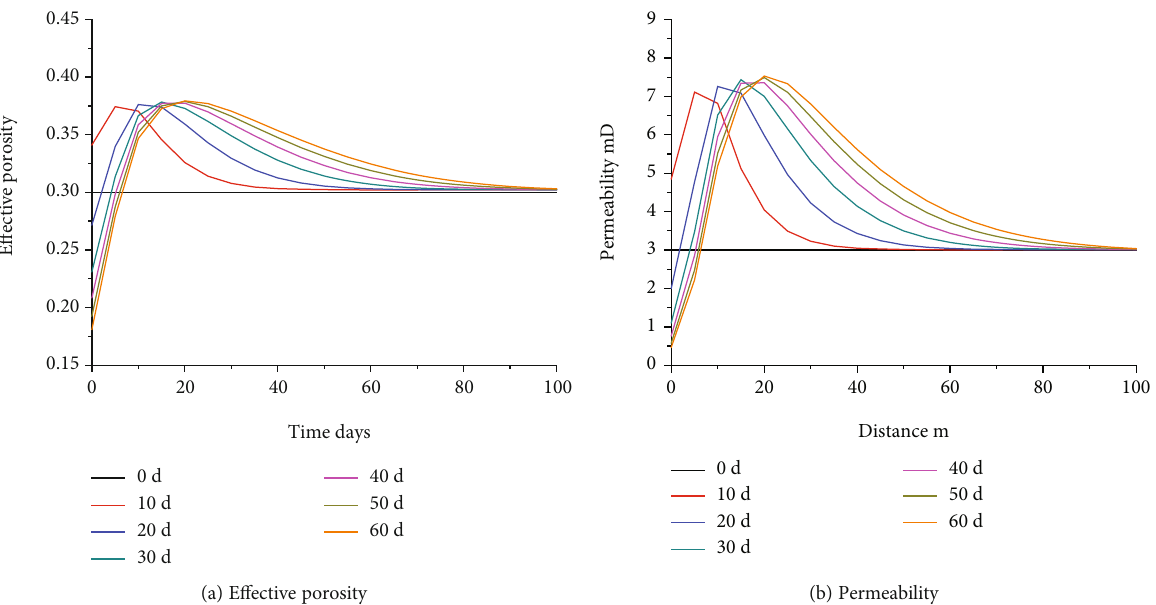
Figure 7: Variation of the sediment physical properties under di ff erent times.